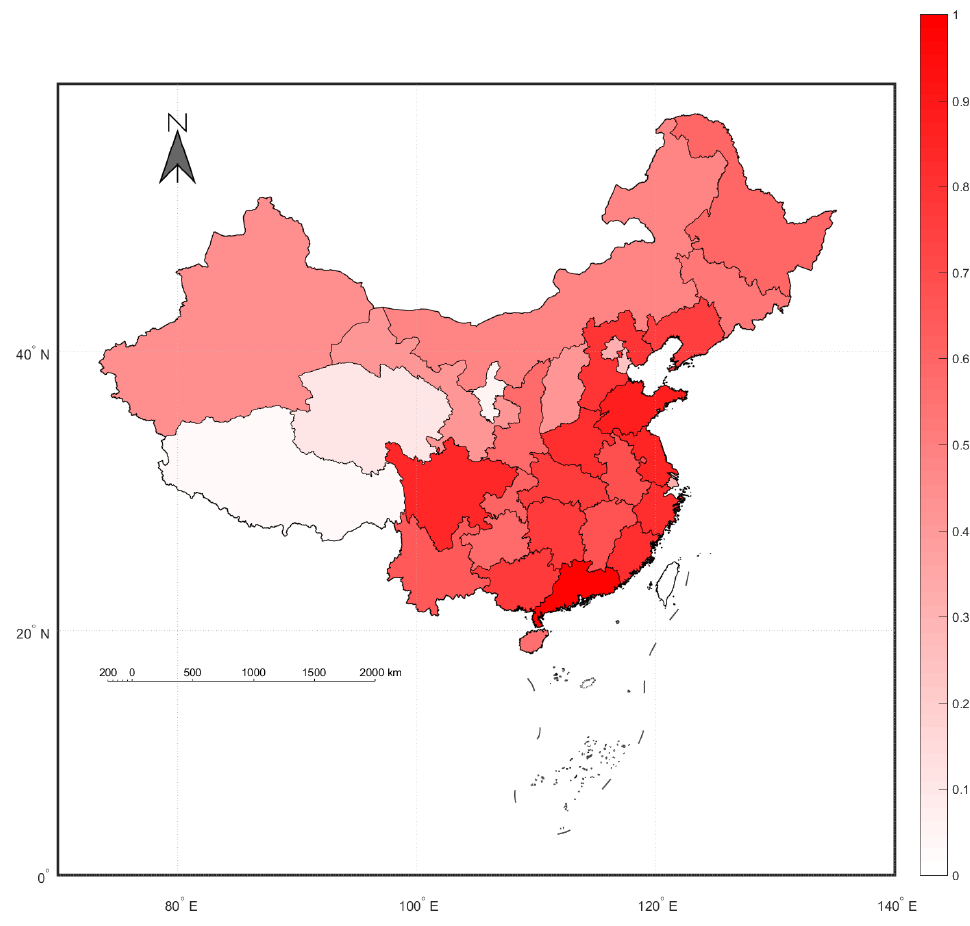
Figure 2. Map of the ATP in China (2000–2019).